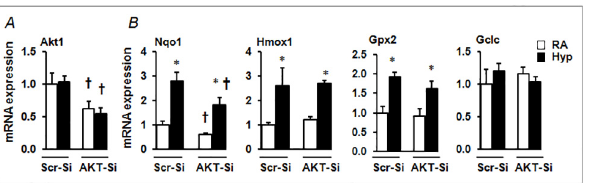
Fig 4. Hyperoxia-induced Nrf2-target gene expression in AKT1-depleted cells. (A) qRT-PCR analysis of hyperoxia-induced Nrf2-target gene expression in cells transfected with either scrambled siRNA (Scr-Si) or AKT1 siRNA. (A) Expression of AKT1 was calculated relative to Scr-Si-transfected room air- exposed samples. (B) Nrf2-target gene expression was calculated relative to Scr-Si-transfected room air- exposed samples. Values from the Scr-si transfected cells exposed to room air are considered as one unit. p (cid:1) 0.05, room air (RA) vs. hyperoxia (hyp); † p (cid:1) 0.05, Scr siRNA vs AKT1-siRNA. Data are expressed as mean ± SEM (n = 3 –